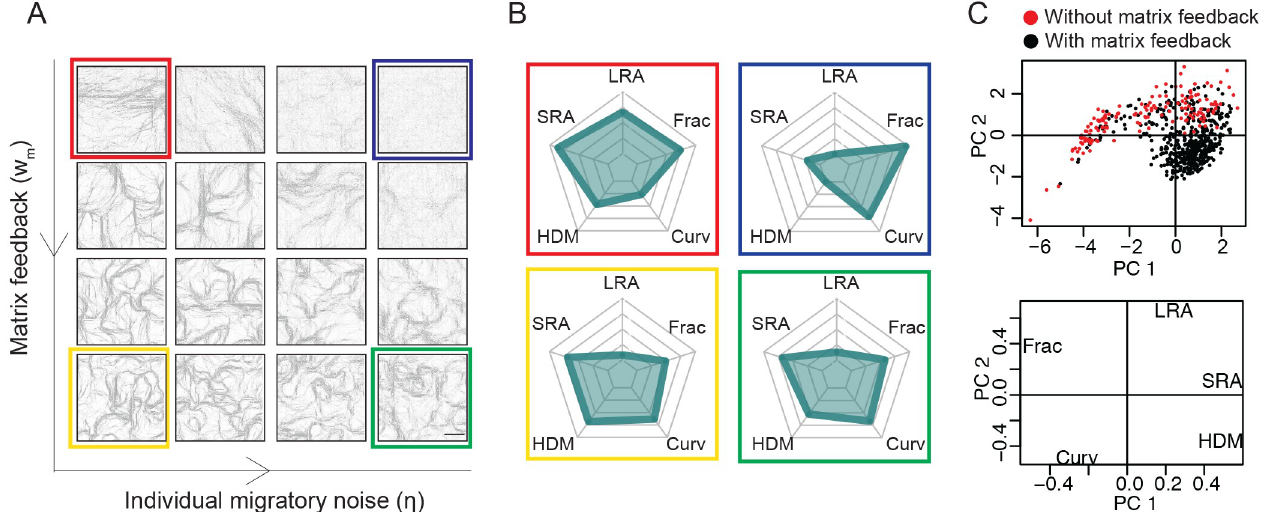
Fig 4. Matrix feedback generates diverse patterning. (A) Matrix patterns produced from varying noise and cell-matrix feedback, cell-cell guidance fixed at w = 0.03. Simulations are of 800 cells (40% confluence) over a time-course of seven days. From left to right noise η = (0, 0.07, 0.14, 0.21), from top to bottom w m = (0, 0.04, 0.12, 0.2). Scale bar represents 100 μ m. (B) Four representative matrix patterns from A are characterized with a starplot according to the metrics of long-range alignment (LRA), short-range alignment (SRA), percentage of high density matrix (HDM), curvature (Curv) and fractal dimension (Frac). (C) PCA of simulations exploring parameter space, reducing metric-space down into two prinicpal components explains 85% of variance and shows the areas in metric-space that can be reached with matrix feedback.